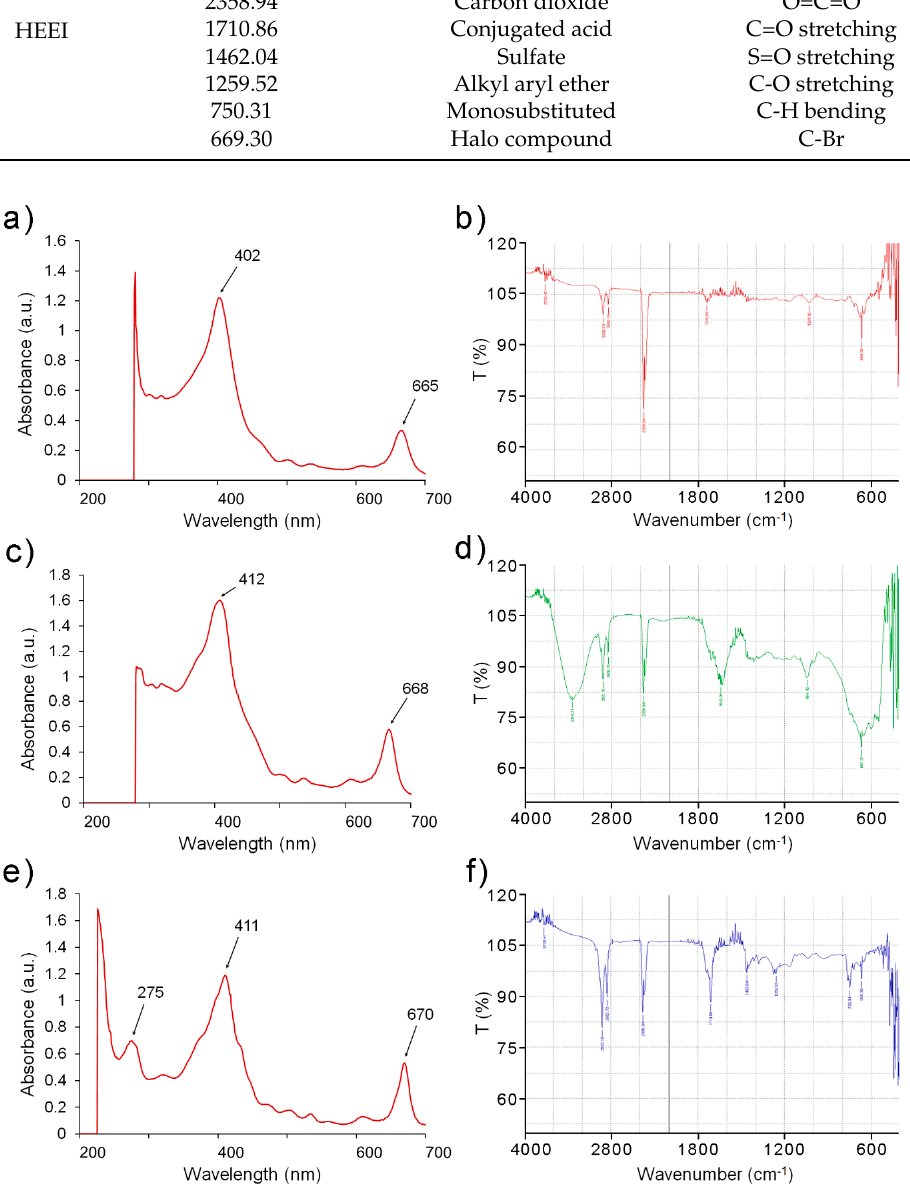
Figure 1. UV-Vis ( a , c , e ) and FT-IR ( b , d , f ) spectral analyses of the extracts of Enteromorpha intestinalis obtained by methanol ( a , b ), ethanol ( c , d ), and hexane ( e , f ). The analyses evidenced minor differences among the spectra corresponding to the different concentration and composition of the bioactive functional groups extracted. Table 2. Functional groups and bonding patterns in the methanolic, ethanolic, and hexane extracts of Enteromorpha intes- tinalis as determined by FT-IR analysis.